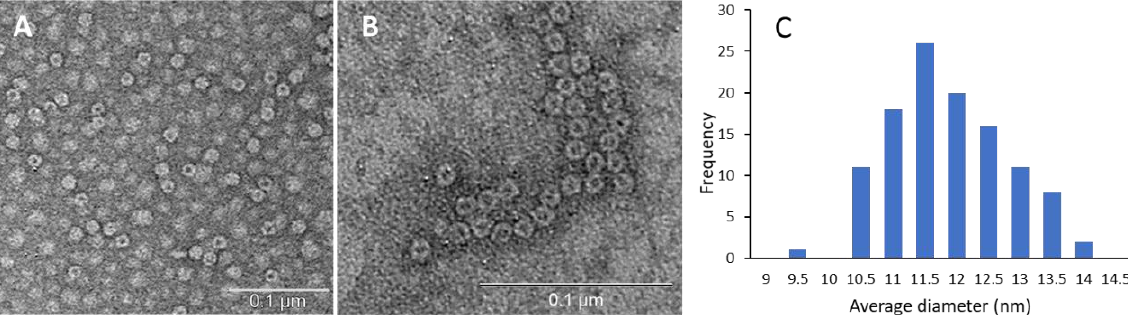
Figure 4. TEM imaging of HumFt R150A/K151A. TEM analysis was performed at different protein dilutions (panel ( A ) 0.5 µg/mL; panel ( B ) 0.005 µg/mL) in the presence of 20 mM HEPES buffer and 50 mM MgCl 2 (scale bar: 0.1 µm). Ferritin nanoparticles show the typical donut morphology with a diameter of 11.58 nm ± 0.9 (panel ( C )).